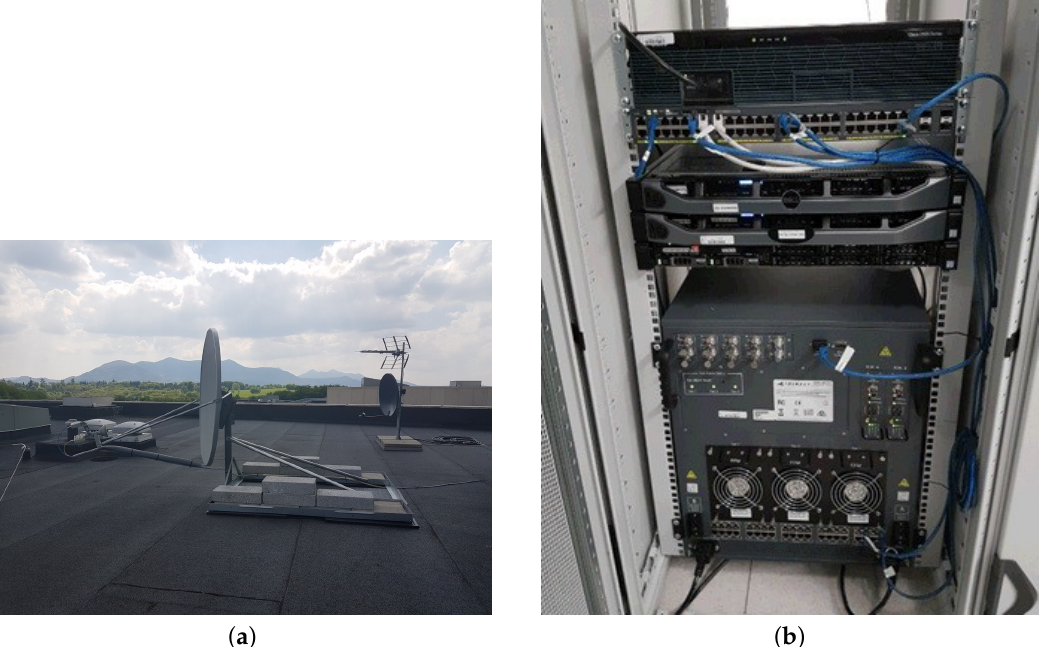
Figure 12. Seamless satellite integration into 3GPP network architecture: hardware setup of the SATis5 testbed. ( a ) The 1.2 m Ku-Band antenna system installation in Killarney, Ireland; ( b ) iDirect Velocity Intelligent Gateway (IGW) satellite hub platform installation in Betzdorf,